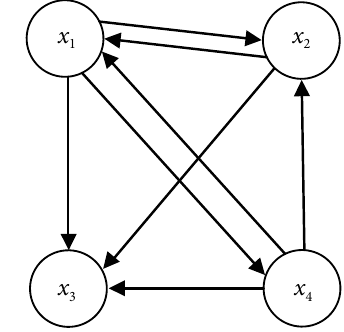
M Fig. 2. Hesitant fuzzy preference graph of 2 H